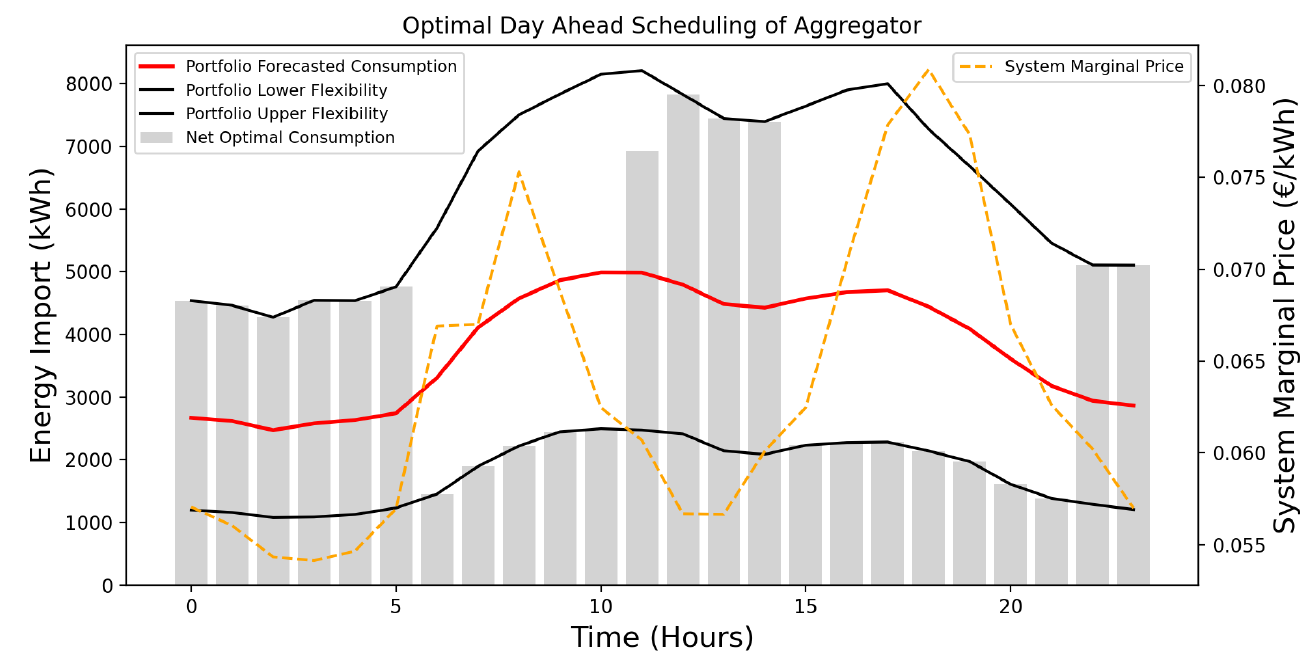
Figure 7. Optimization for aggregator